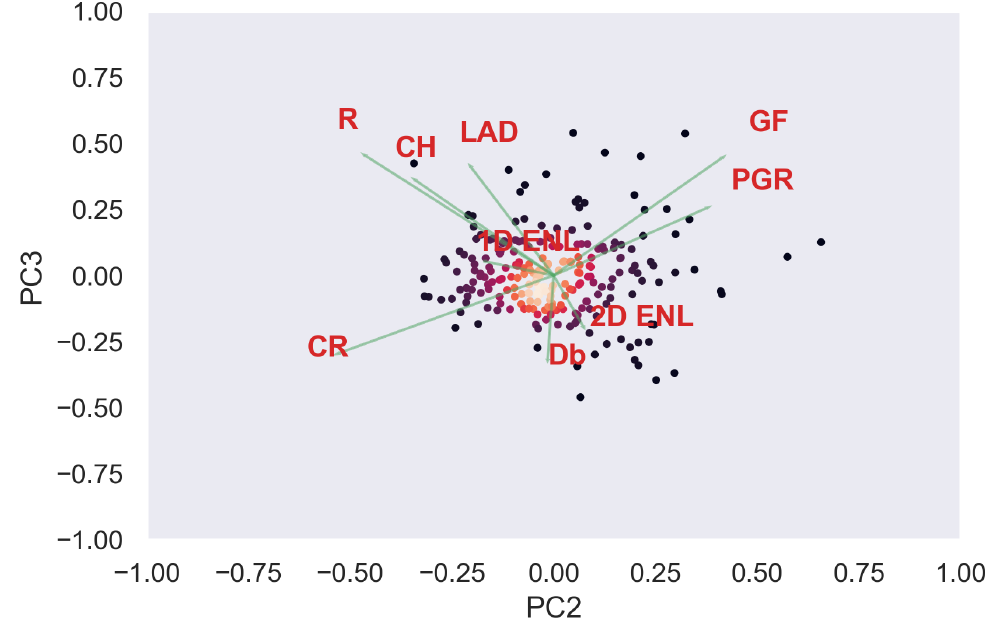
Figure A57. TLS PCA band 2 and 3 loadings at 5m grid